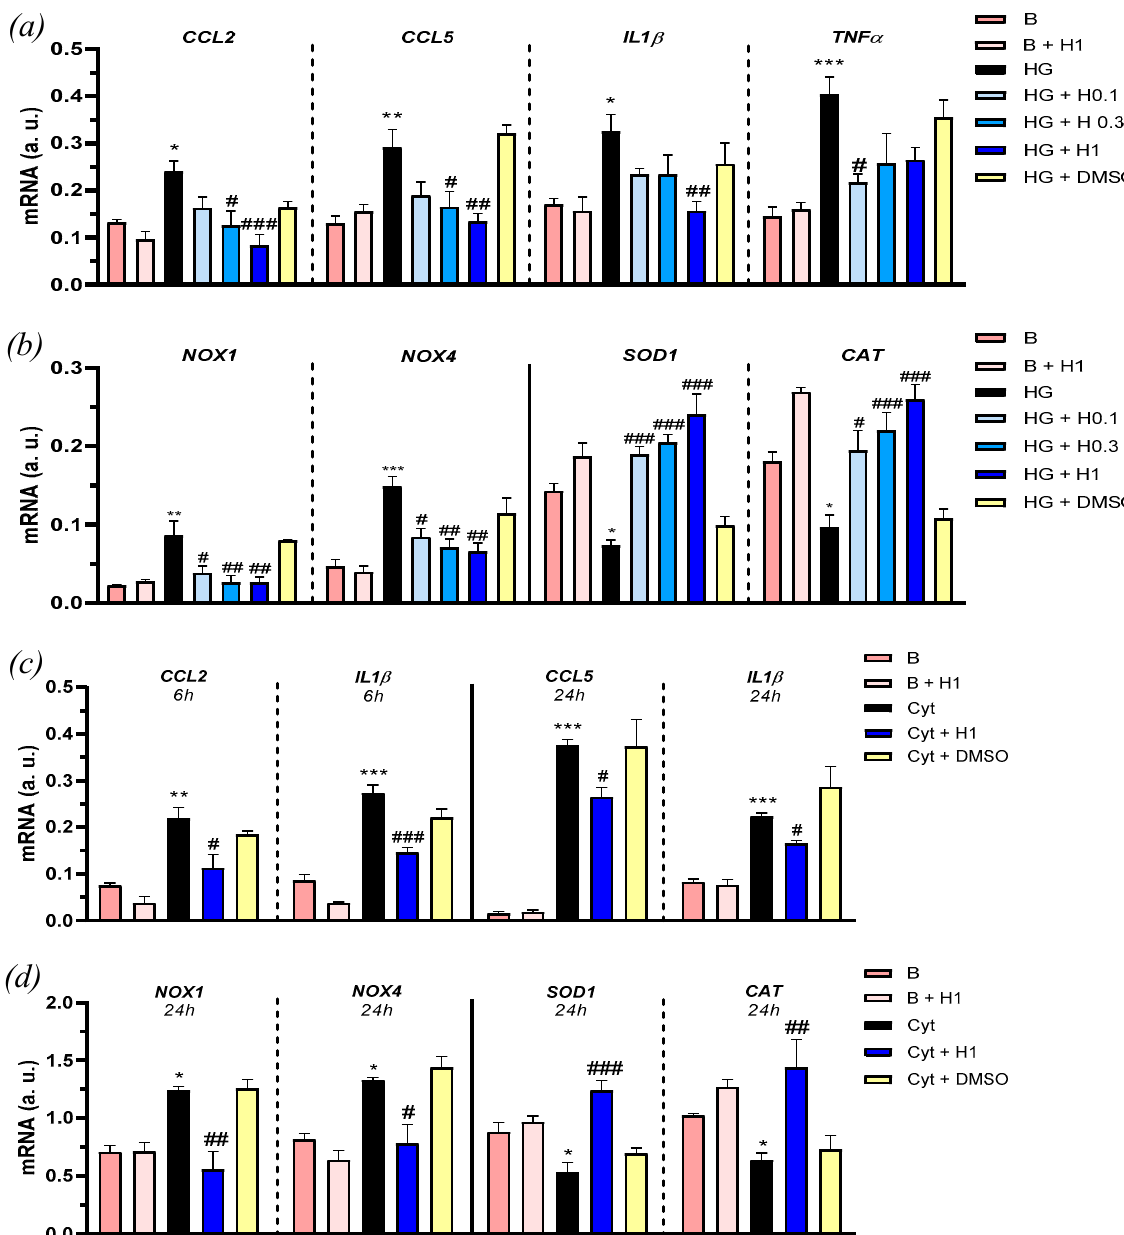
Figure 2. Effects of hidrosmin on inflammation and oxidative stress gene expression in HK2 cells. Real-time PCR analysis in HK2 cells exposed to medium with 0.5% FBS (B, basal) containing high-glucose (HG, 24 h) ( a , b ) or cytokines (Cyt, 6 and 24 h) ( c , d ) in the absence/presence of hidrosmin (H0.1, H0.3 and H1, mM doses) or vehicle of its highest dose (0.5% DMSO). Bars represent the mean ± SEM of 3–4 experiments in duplicate. * p < 0.05, ** p < 0.01 and *** p < 0.001 vs. basal (B); # p < 0.05, ## p < 0.01 and ### p < 0.001 vs. stimulus (HG or